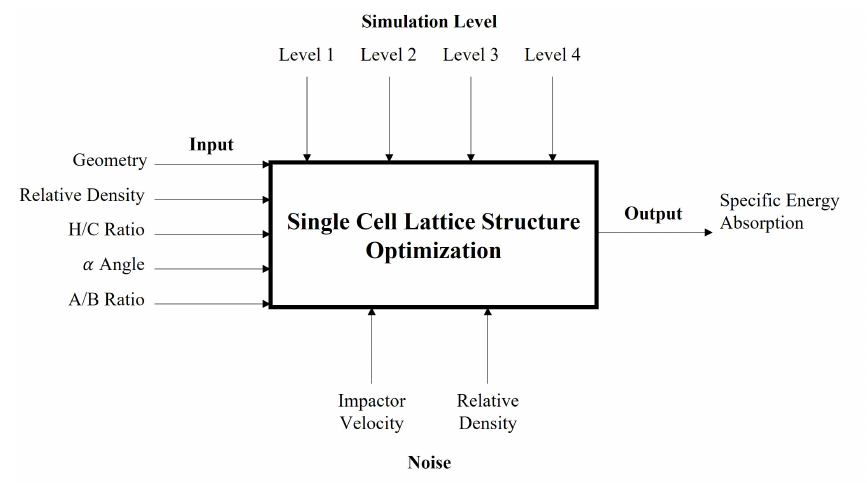
Figure 3. Process Diagram of The Single-Cell Lattice Structure